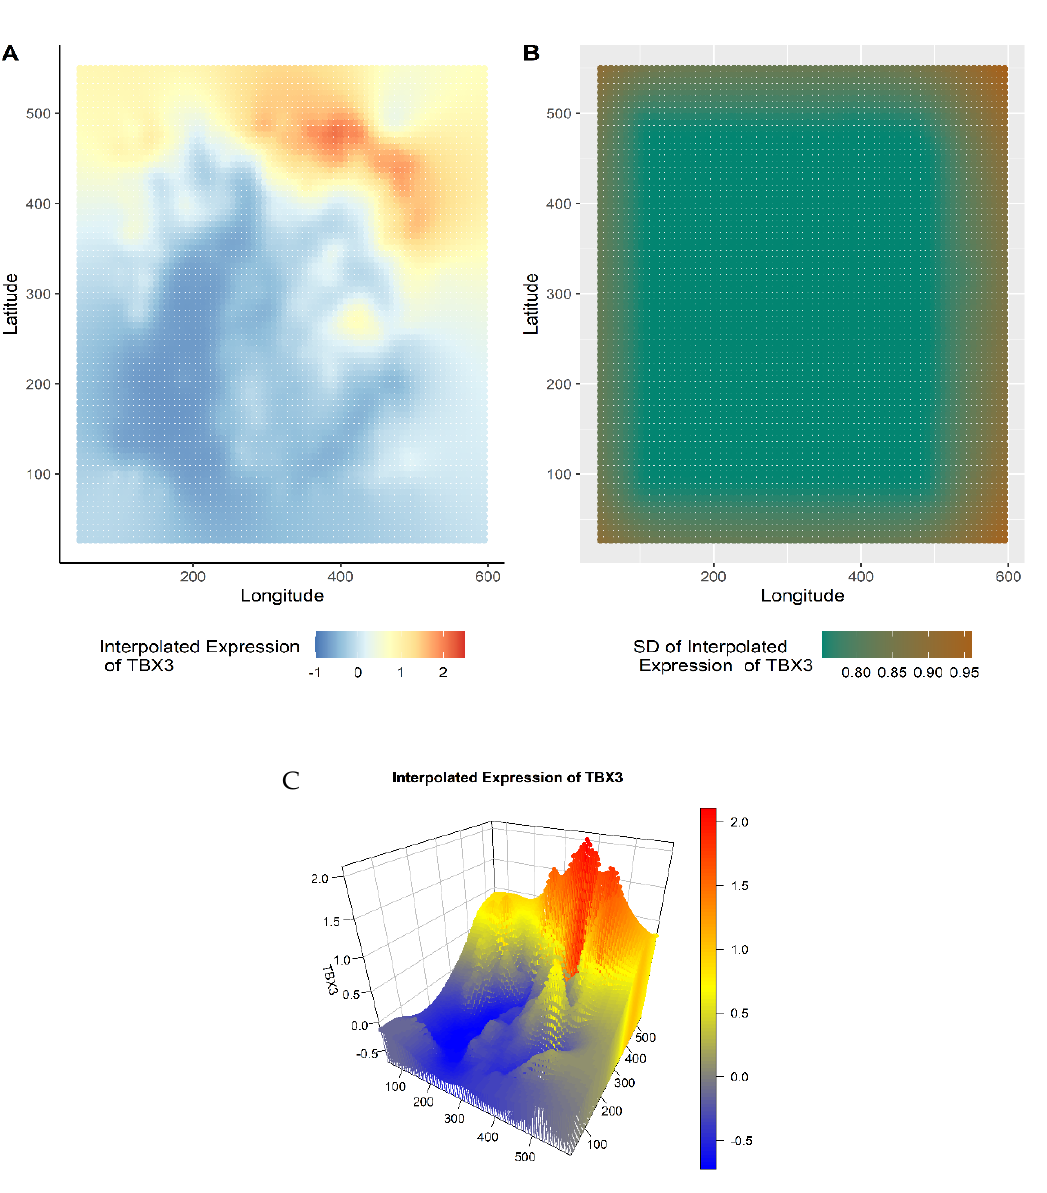
Figure 2. Gene expression landscape generated by geostatistical modeling. Taking the gene TBX3 as an example, plots ( A ) and ( B ) show kriging-predicted value Z of gene expression at each point of the tissue space and the associated standard error, respectively. Plot ( C ) is a snapshot of the interactive 3D visualization of the plot ( A ). The x and y dimensions define the tissue space while the z dimension in plot ( C ) represents the kriging-predicted 𝑍 expression.